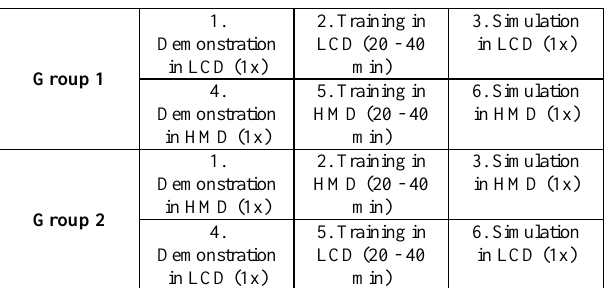
E XPERIMENTAL SETUP FOR THE INITIAL TEST .